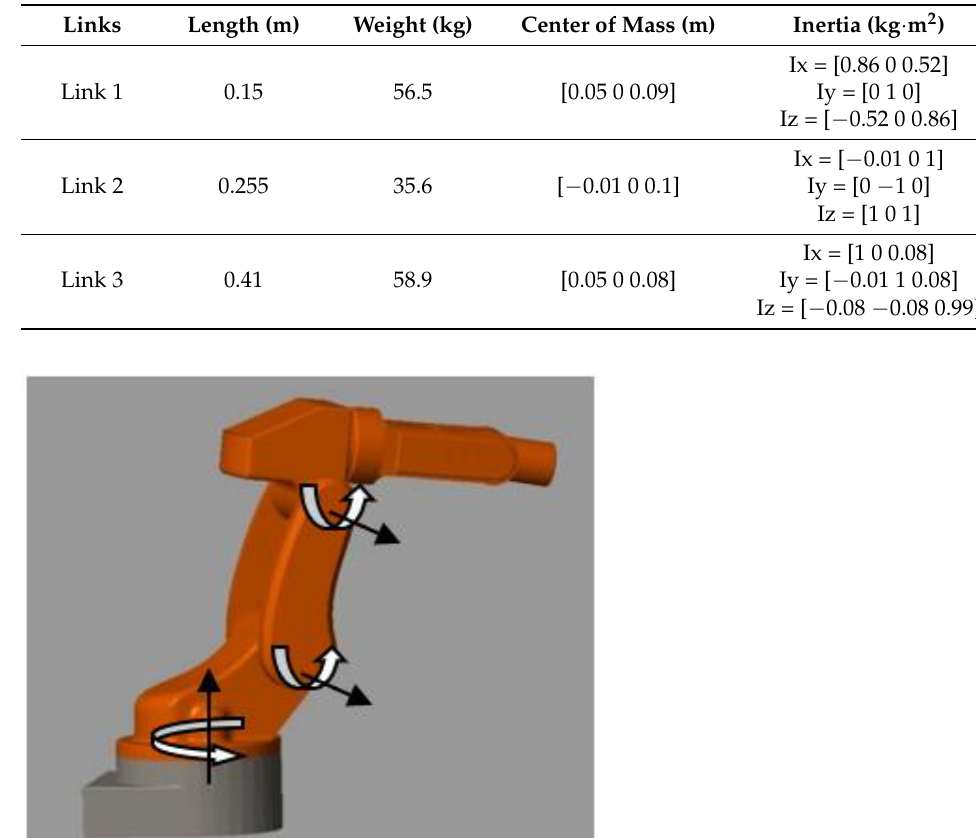
Table 1. Dynamics Parameters of 3-DOF Robot Manipulator.